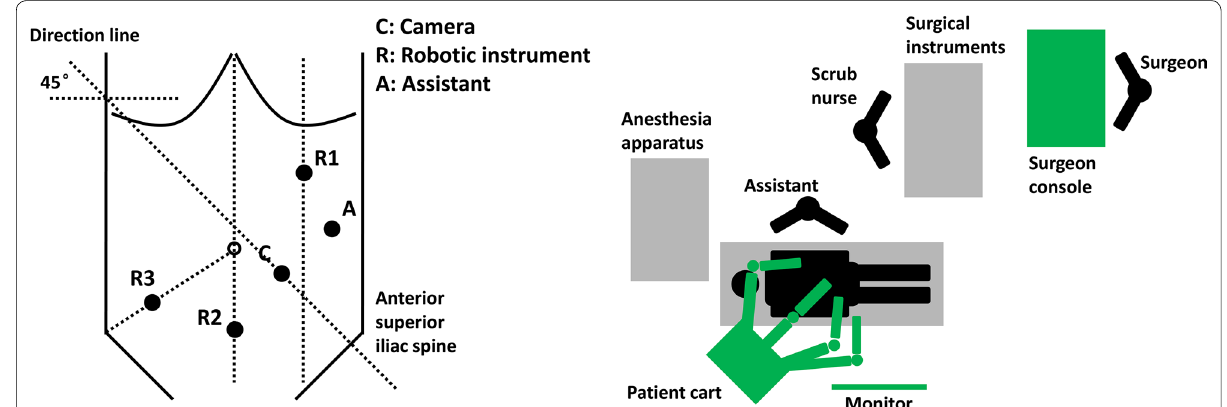
Fig. 4 Trocar location and operating room setup for robot-assisted radical resection of right-sided colon